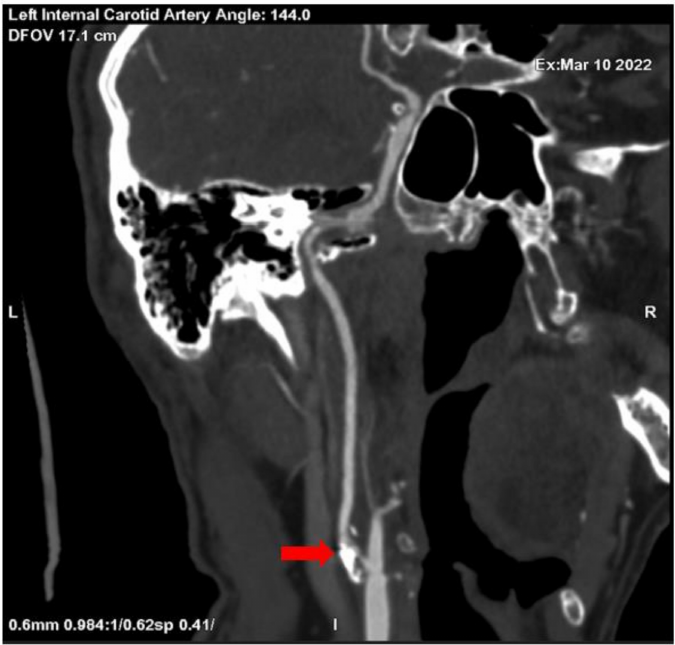
Figure 1. Subocclusion in the proximal segment of the left internal carotid artery (CTA) (red array).